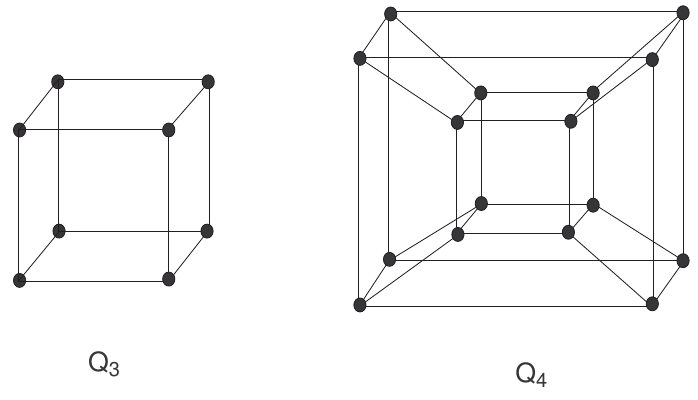
Figure 2. The hypercube graphs Q 3 and Q 4 .